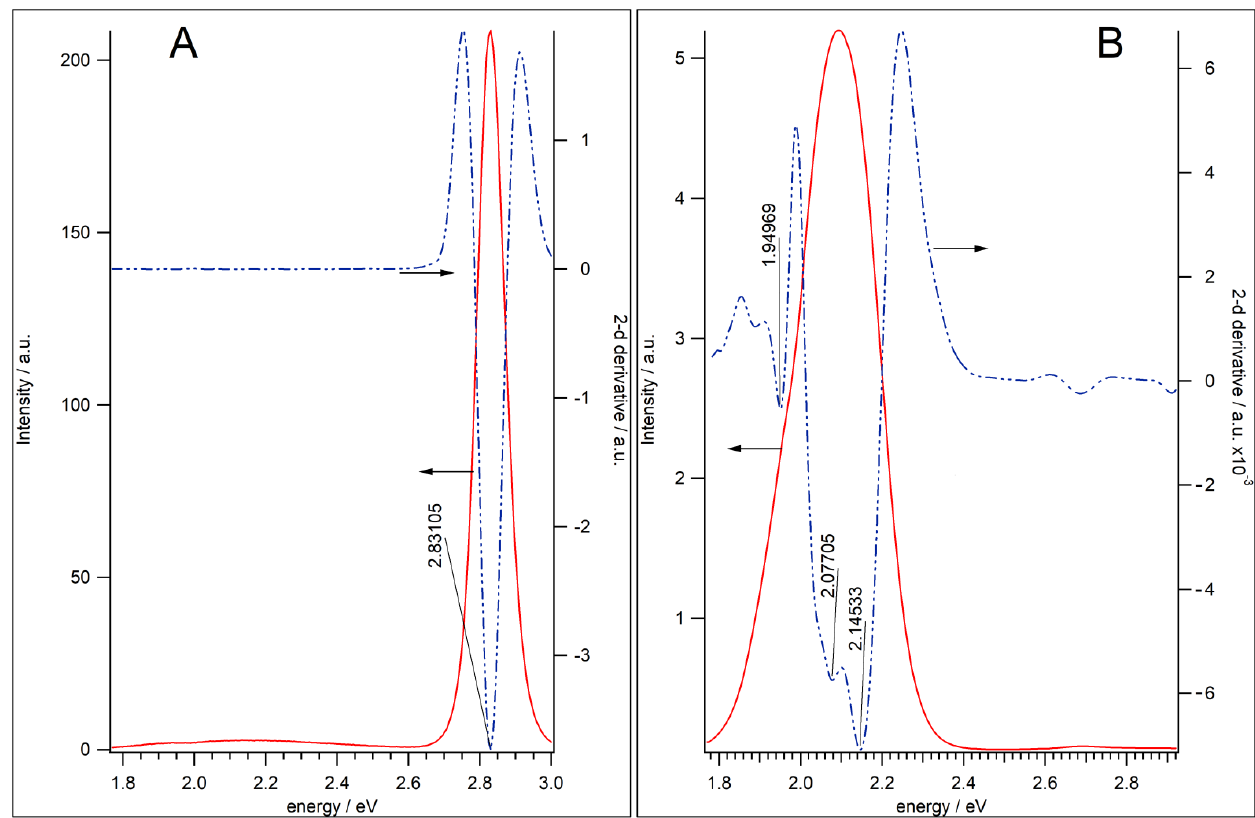
Figure 2. PL spectra of undoped QD-1 ( A ) and Mn 2+ -doped QD-2 ( B ) samples. The PL spectra (red solid lines, left y-axis) are compared with the second derivatives of spectra (blue dash-dotted line, right y-axis).